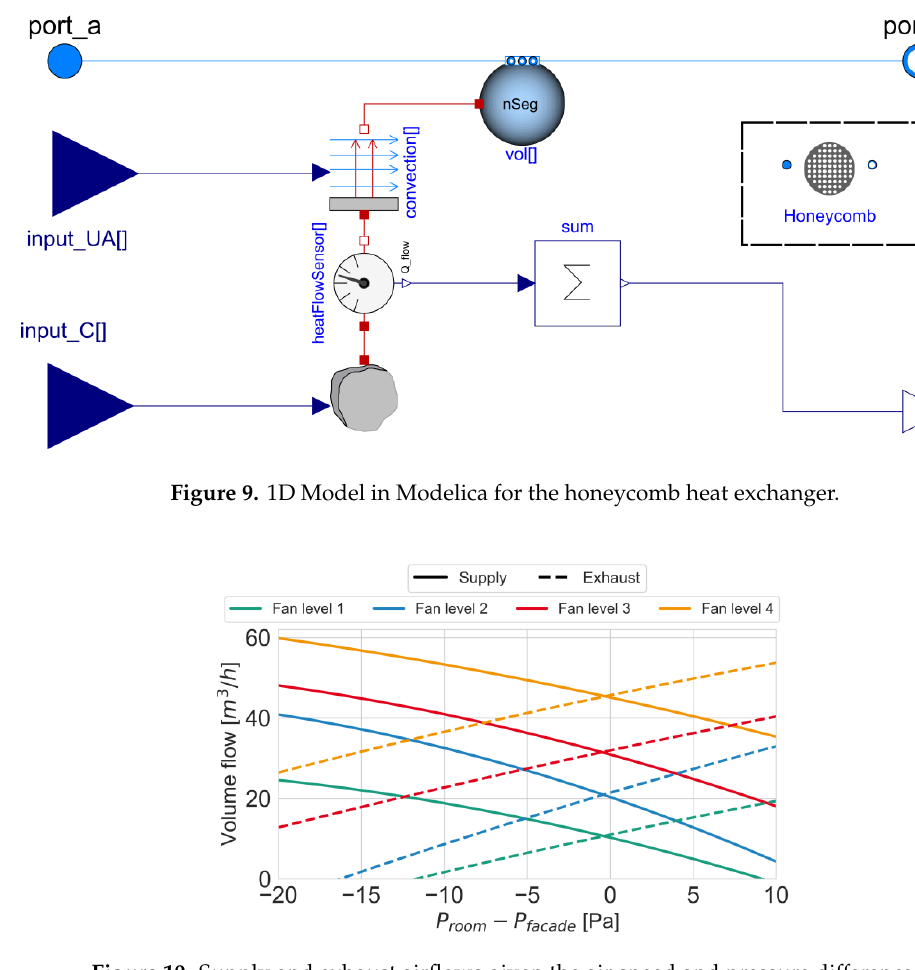
Figure 9. 1D Model in Modelica for the honeycomb heat exchanger.